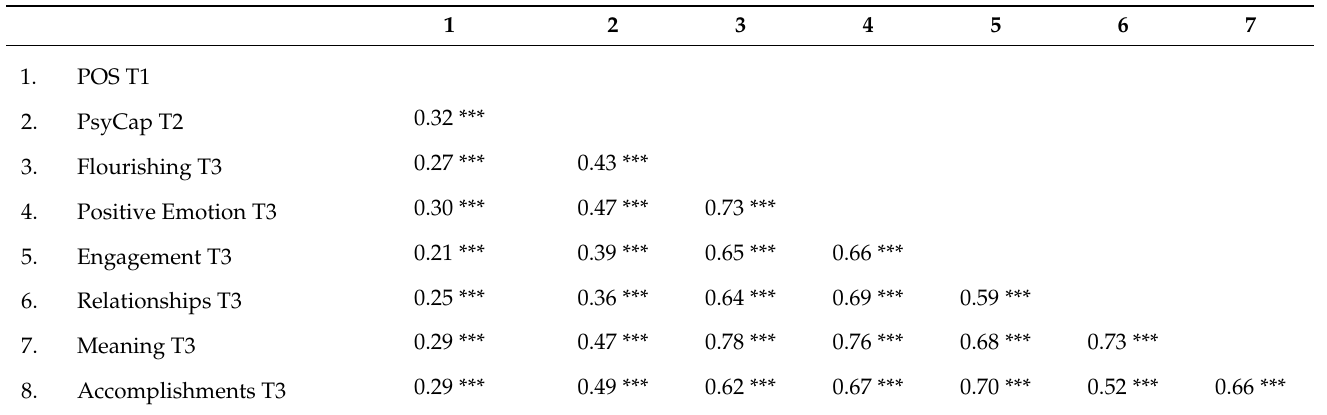
Table 1. Zero-order correlations between